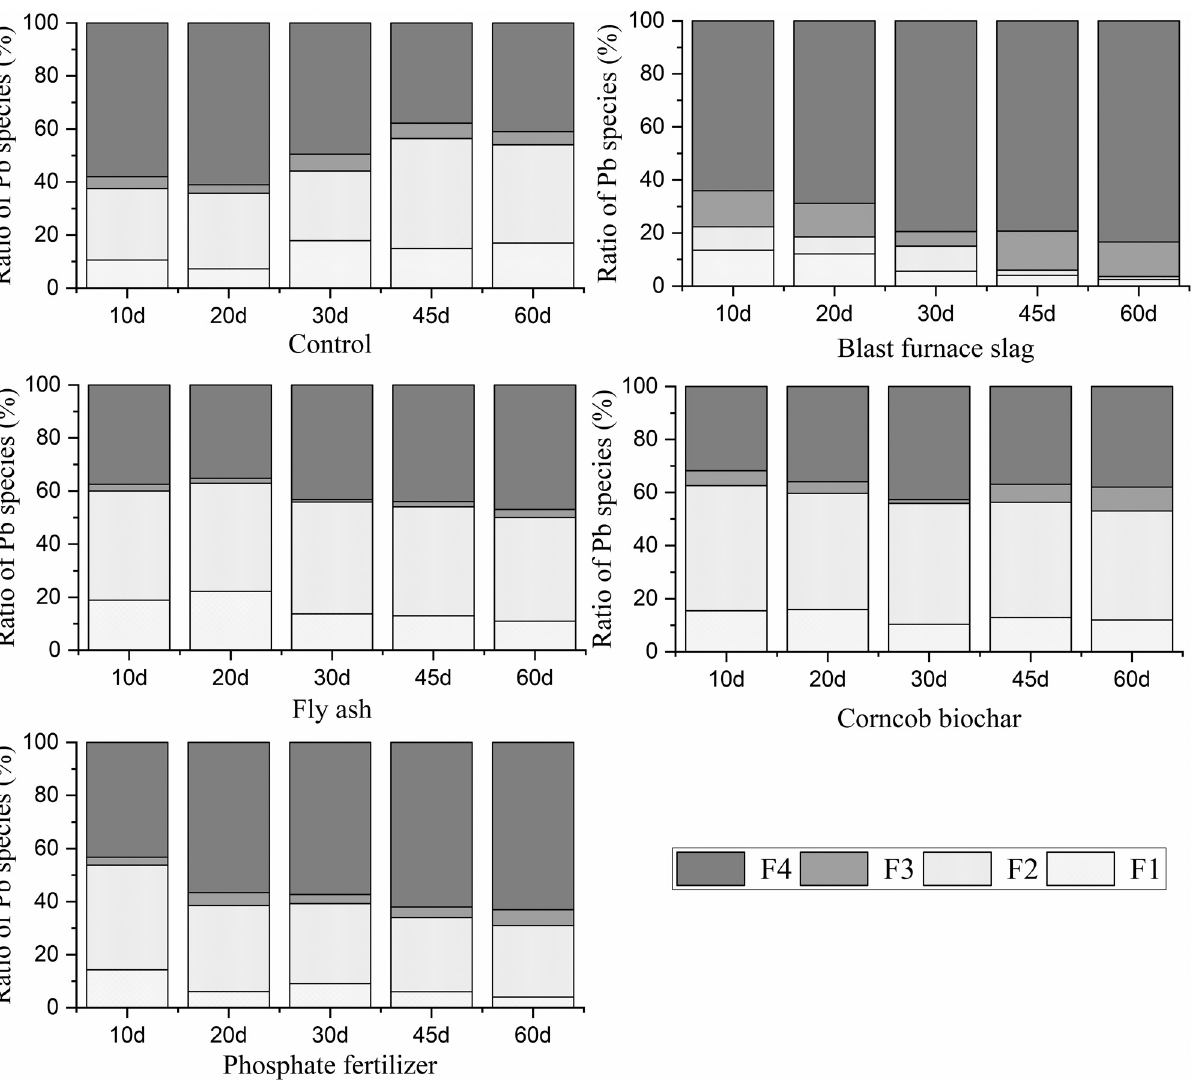
Figure 3: Comparison of the changes of Pb fractions in soil with di ff erent treatments. F 1 , F 2 , F 3 , and F 4 , respectively, indicates acid - soluble, reducible, oxidizable, and residual Pb in